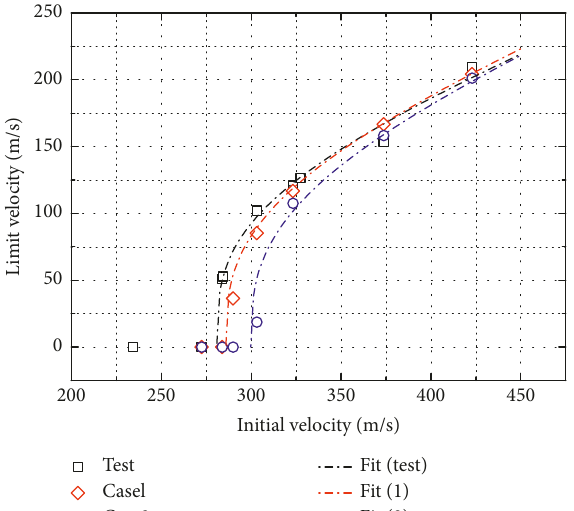
Figure 8: Initial versus residual velocity data and fitting curves of test and numerical simulation for Q235B steel targets.